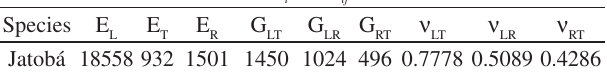
and G in MPa ). i ij